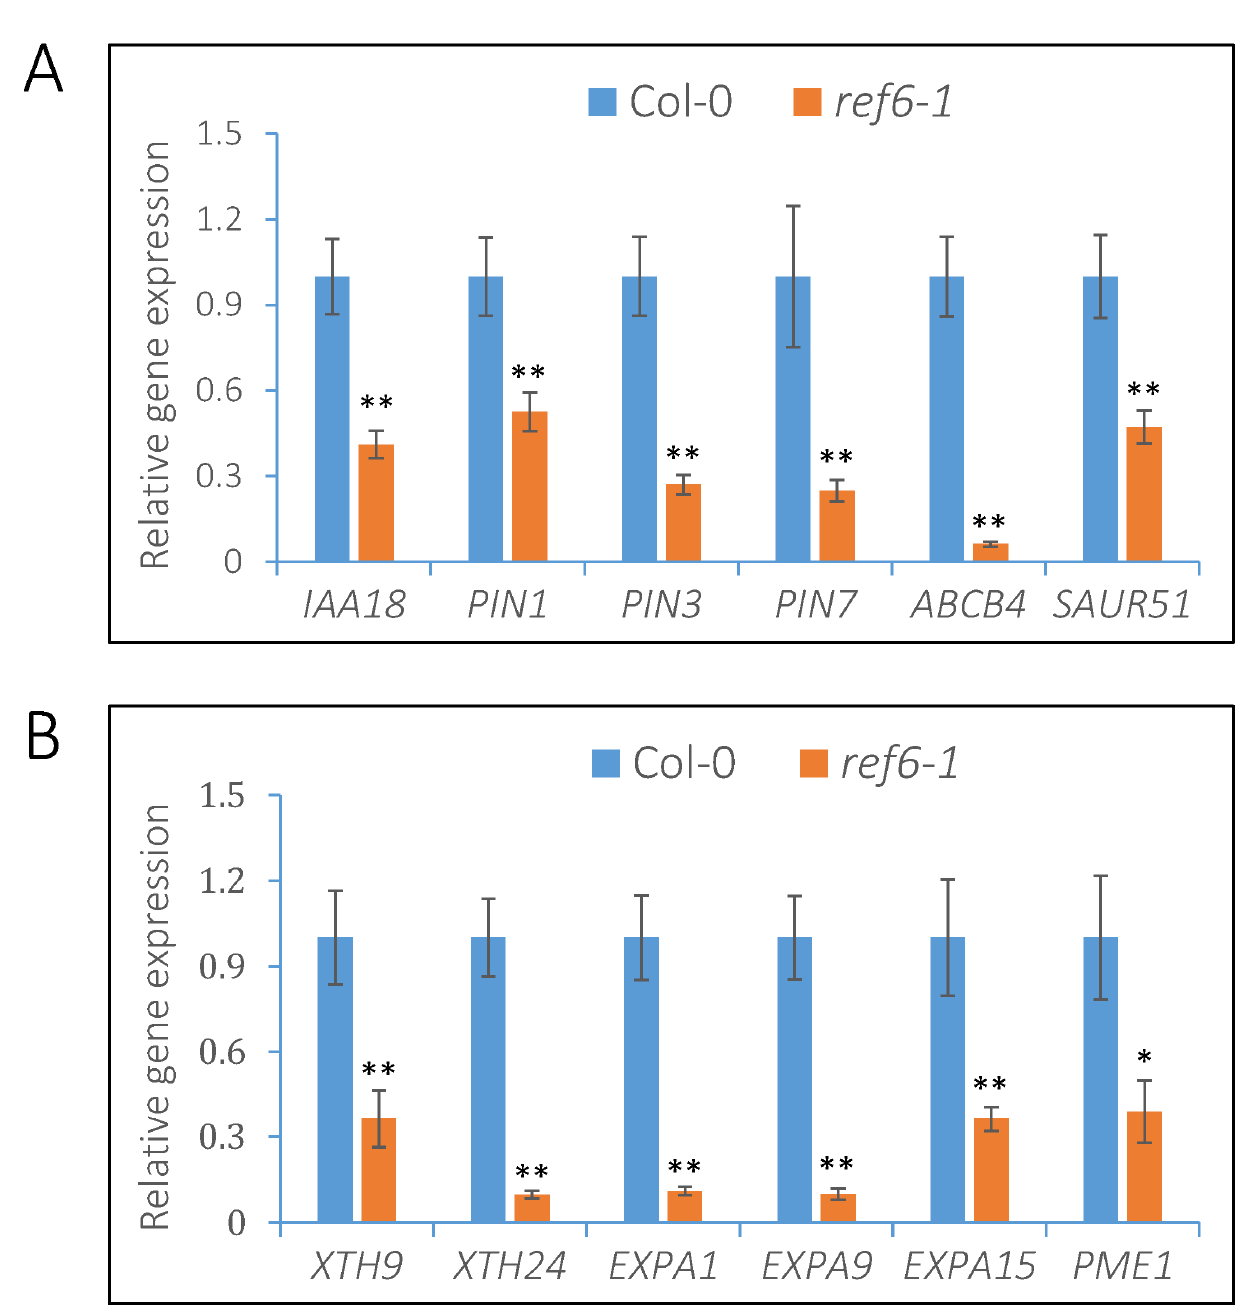
Figure 7. REF6 activates the expression of auxin-signaling- and cell-wall-loosening-related genes in imbibed seeds after FR/R irradiation. ( A ) qRT-PCR analysis of the expression levels of auxin-signaling-related genes in ref6-1 mutant. ( B ) qRT-PCR analysis of the expression levels of cell-wall-organization-related genes in ref6-1 seeds. PP2A was used as an internal control. Values are shown as means ± SD (* p < 0.05, ** p < 0.01, difference from Col-0, n = 3).